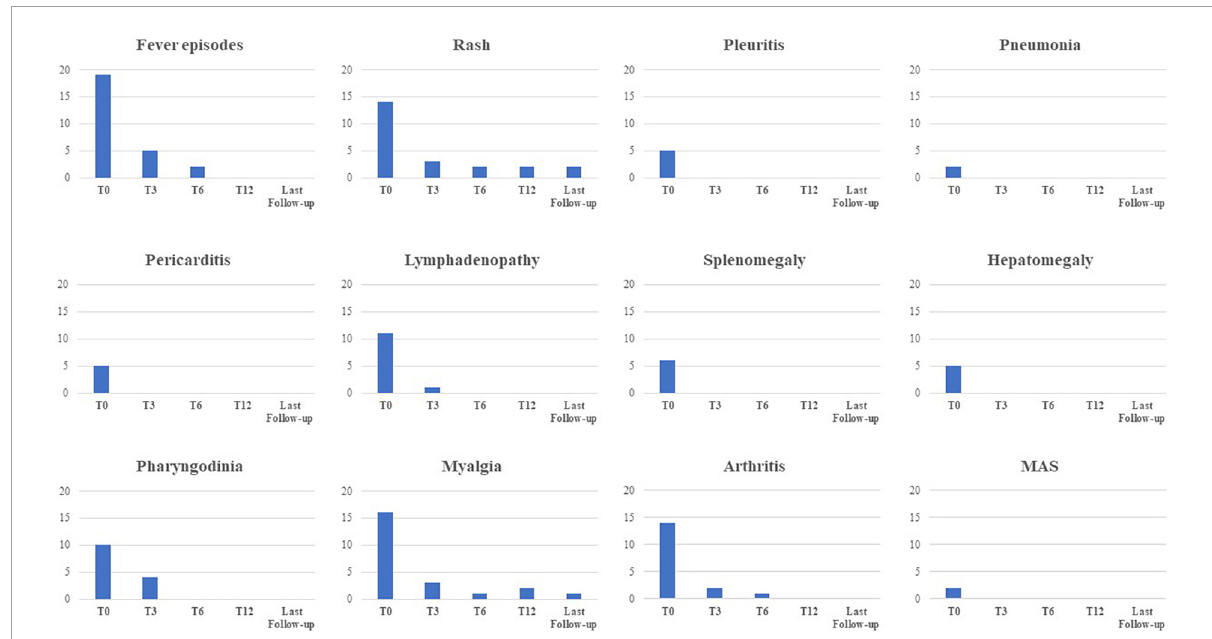
FIGURE4 Frequency of the main clinical manifestations related to Still’s disease at the start of canakinumab and at the following time-points. MAS, macrophage activation syndrome.